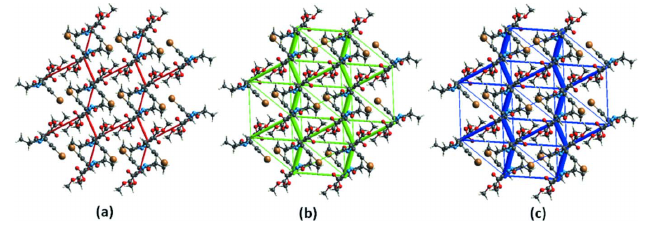
Figure 5 Energy framework of the title compound viewed along [001] showing ( a ) Coulombic energy, ( b ) dispersion energy and ( c ) total energy.